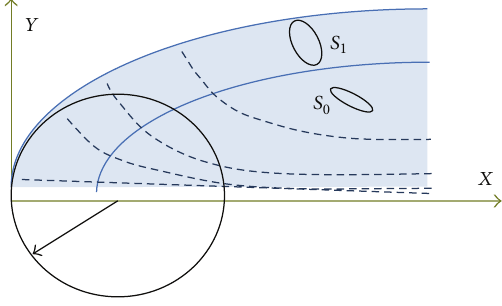
Figure 3: Schematic representation of the droplet in VOCs atmo- sphere: gas diffusion results in the formation of outer layer with lower order parameter (see also explanations in the text).